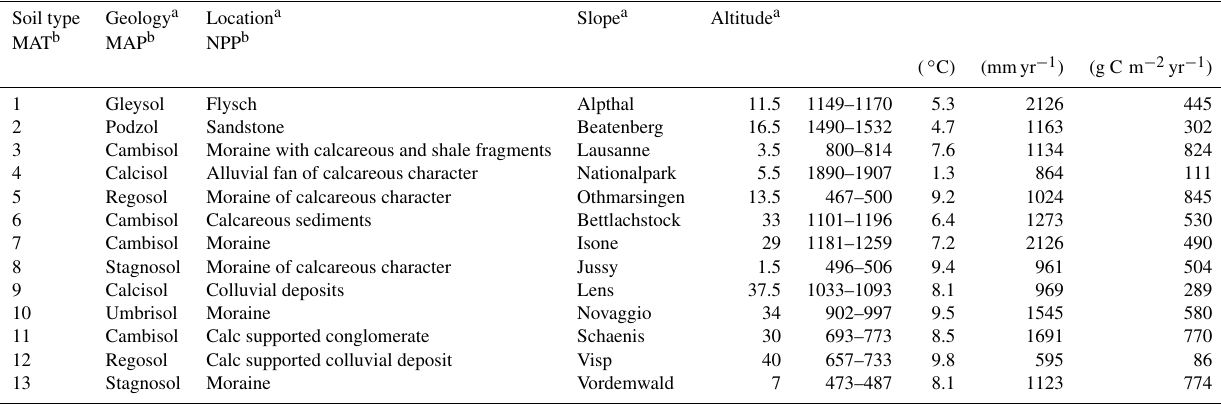
Table 1. Overview of WSL LWF sampling locations and main climate variables. Mean average air temperature (MAT) and mean average precipitation (MAP) and Net Primary Production (NPP) measured between 1980 and 2010. Numbers in first column correspond to site numeration of Fig. 1. Soil classification in accordance with WRB (2006), altitude inma.s.l., soil and slope as a percentage of 90 ◦ (Etzold et al., 2014; Walthert et al., 2003).